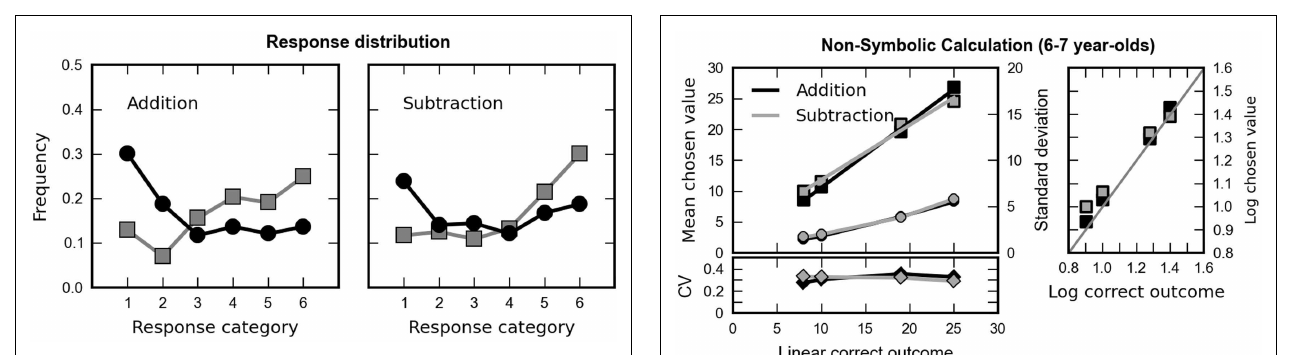
FIGURE 4 | Left column: mean responses (chosen values, squares) of the children and standard deviations (circles) plotted against the correct outcome for addition (black) and subtraction problems (gray) . The lower part depicts the coefficient of variation (CV, diamonds) – that is, the ratio of standard deviation and mean chosen value, plotted against the correct outcome. A constant coefficient of variation indicates that variability of chosen values increased proportionally with mean chosen value. In turn, this can be understood as an instantiation ofWeber’s law. Right column: the logarithm of the correct outcome plotted against the logarithm of the mean value chosen by the children for addition (black) and subtraction (gray).The gray line indicates a ratio of 1 – that is, perfect